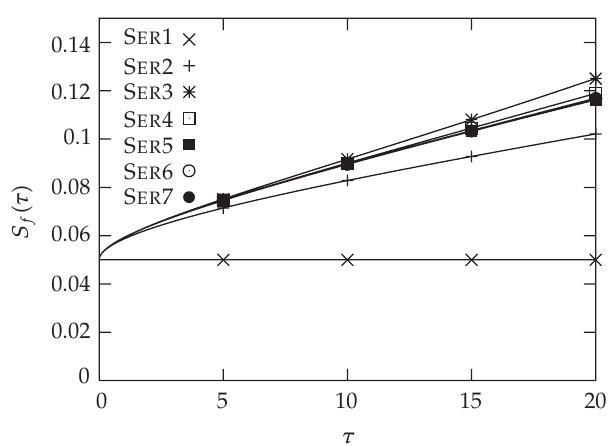
Figure 1.1 . Exercise boundary for the call from ( 1.3 ) for E = 0 . 9, r